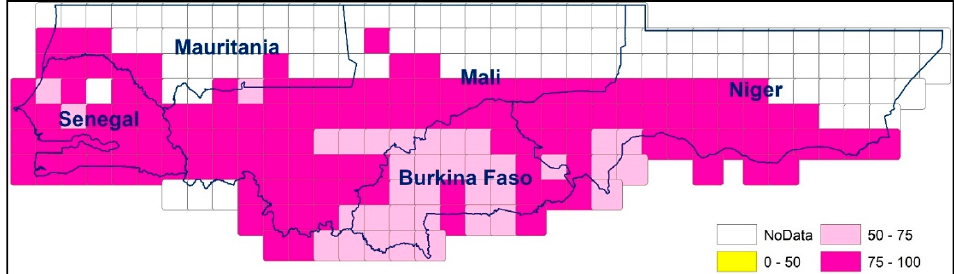
Figure A2. Overall accuracy (OA) at grid level.